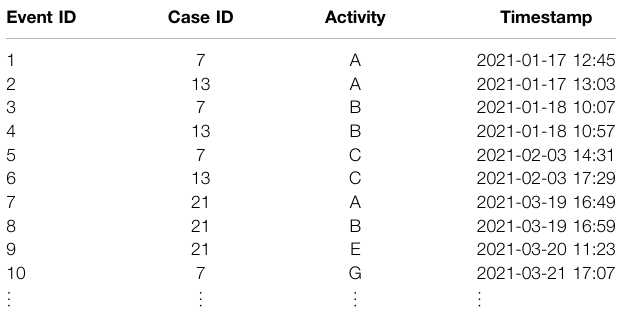
TABLE 1 | An example event log excerpt. Each row is an event and corresponds to the execution of an atomic activity in the process. An event shall minimally contain the values for a case identi fi er, an activity name, and a